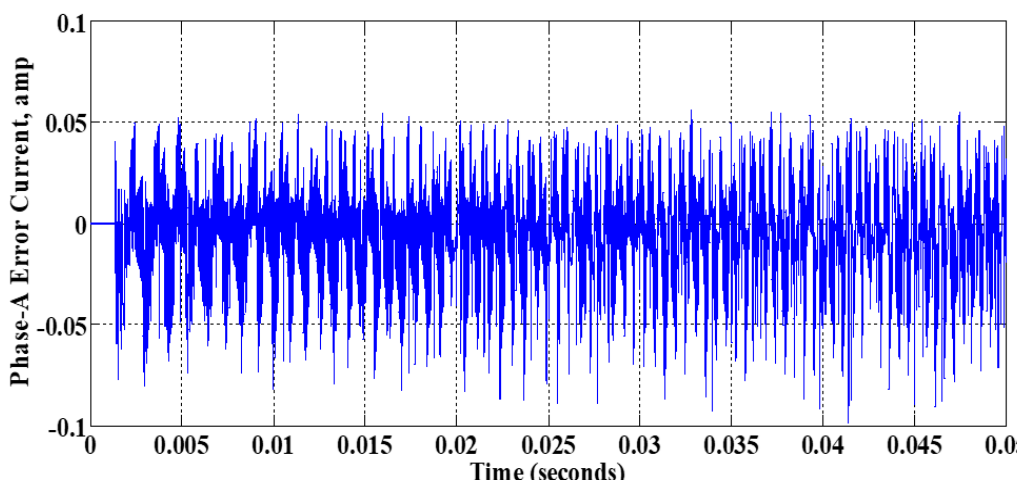
Figure 10. Error between the estimated and actual currents of phase-A.